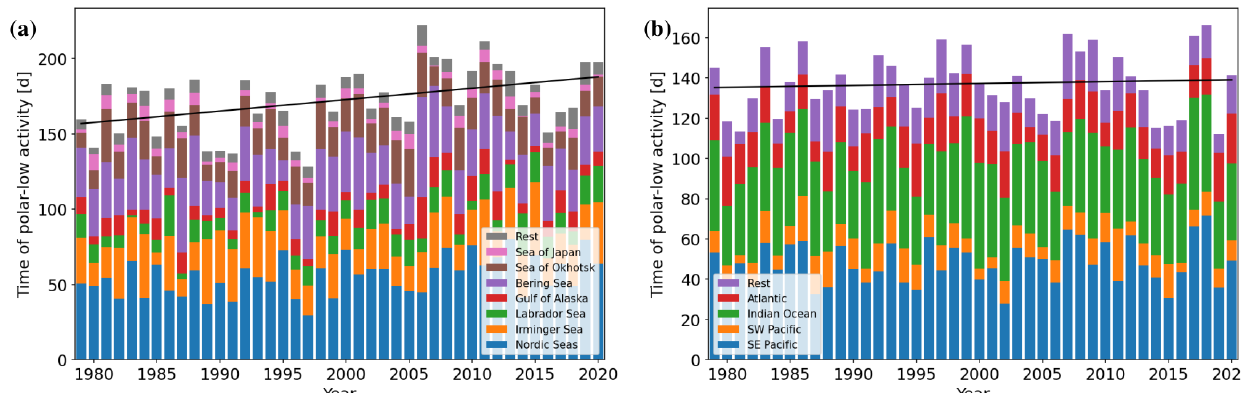
Figure 6. The annual time of polar-low activity for (a) the Northern Hemisphere and (b) the Southern Hemisphere. Colours denote the contribution of specific regions marked by boxes in Fig.